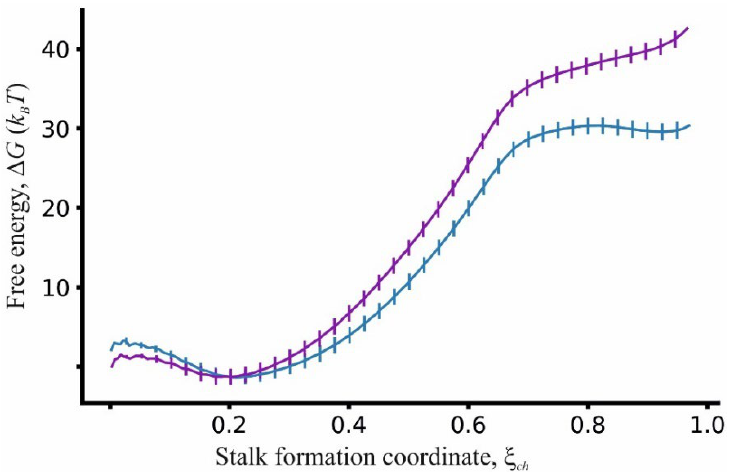
Figure 6. Dependencies of the free energy ∆ G , measured in the units of k B T , on the stalk formation coordinate ξ ch for pure DOPC membranes. The energy of the bilayer–bilayer system is plotted as a purple curve and the energy of the bilayer–monolayer system is plotted as a cyan curve.